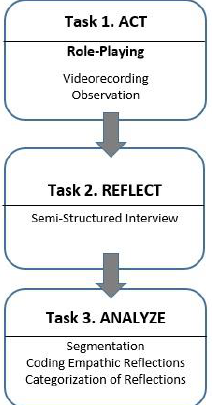
Figure 1. The Structure of the Study (Developed by